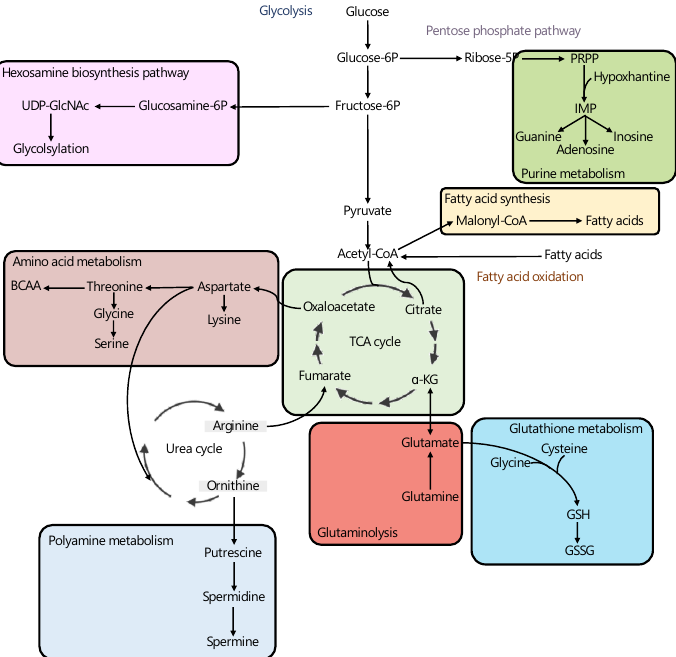
Figure 2. Overview of metabolic pathways most consistently reported to be altered in PCa in the multi-omics studies reviewed in this article, including: hexosamine biosynthesis pathway [64,65], purine metabolism [61], fatty acid synthesis [58,59,63], amino acid metabolism [61], TCA cycle [60,62], glutathione metabolism [58], glutaminolysis [62,66] and polyamine metabolism [58,63]. Thick lines highlight the metabolic pathways found to be upregulated in PCa tumors when compared with benign prostate tissue. References corresponding to the multi-omic studies describing alterations in each metabolic pathway are included. α -KG: alpha-ketoglutarate, Fructose-6P: fructose-6-phosphate, Glucosamine-6P: glucosamine-6-phosphate, Glucose-6P: glucose-6-phosphate, IMP: inosine monophosphate, PRPP: phosphoribosyl diphosphate, Ribose-5P: ribose-5-phosphate.